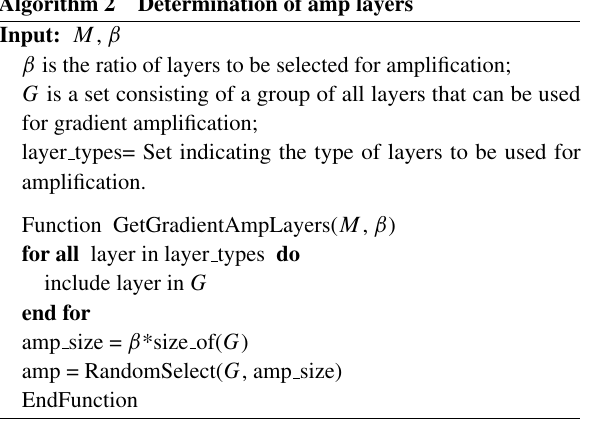
Algorithm 2 Determination of amp layers